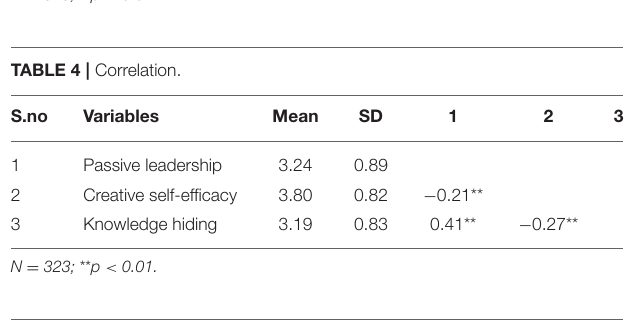
TABLE 5 | Hypotheses